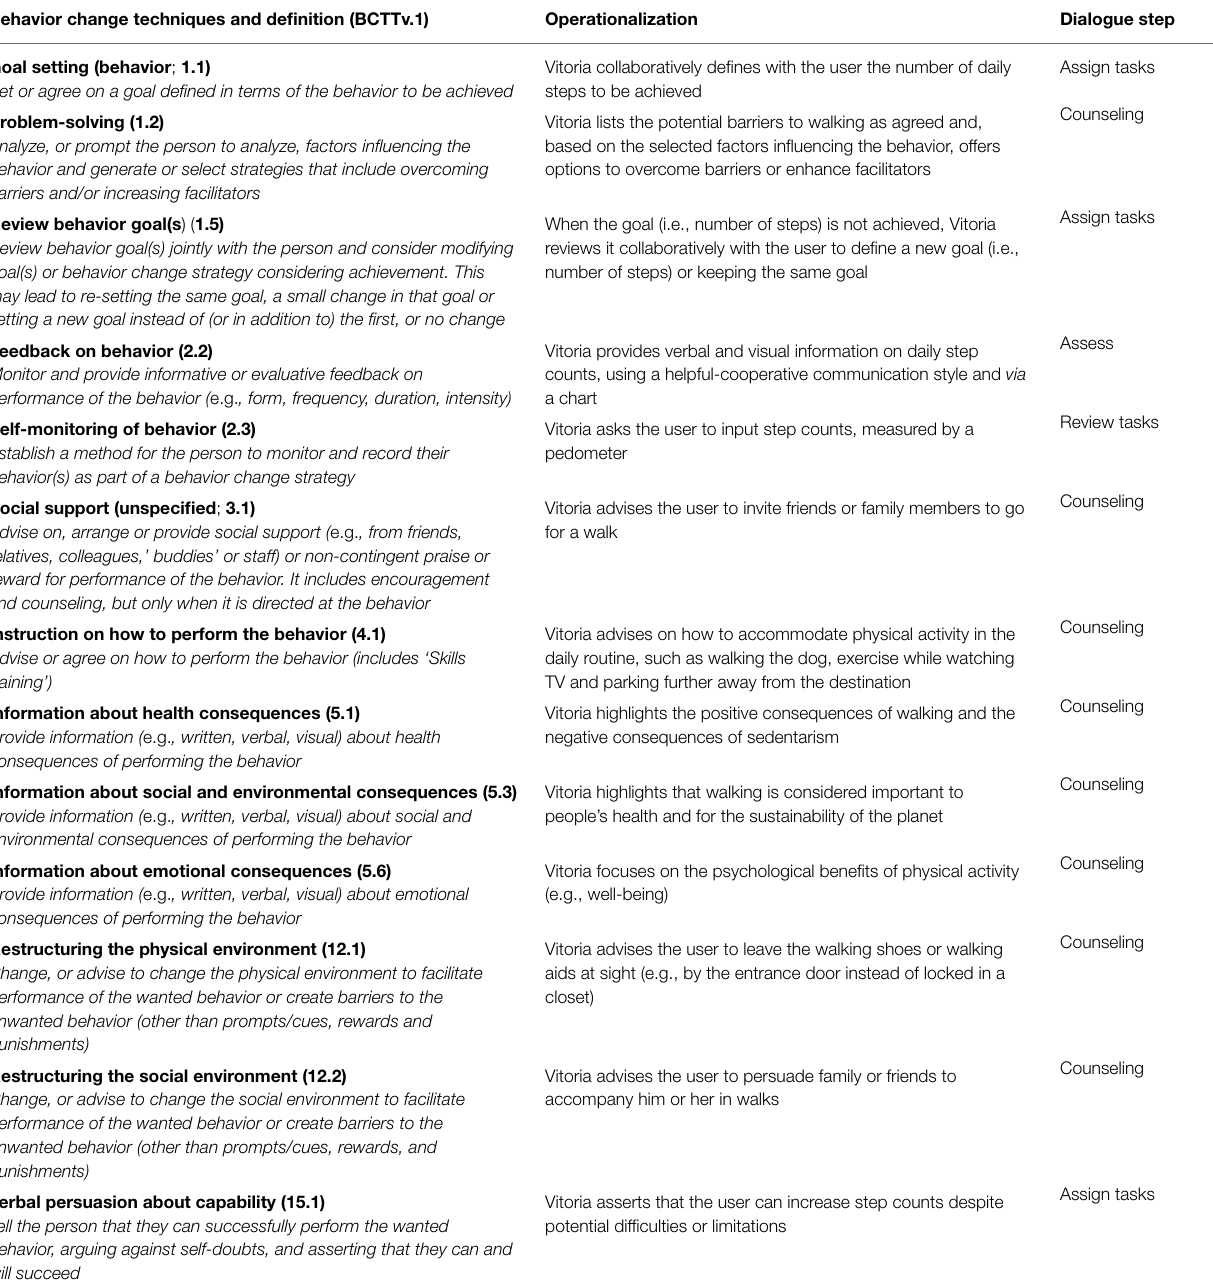
TABLE 1 | Description of the BCTs and operationalization used by the anthropomorphic conversational agent. Behavior change techniques and definition (BCTTv.1) Operationalization Dialogue